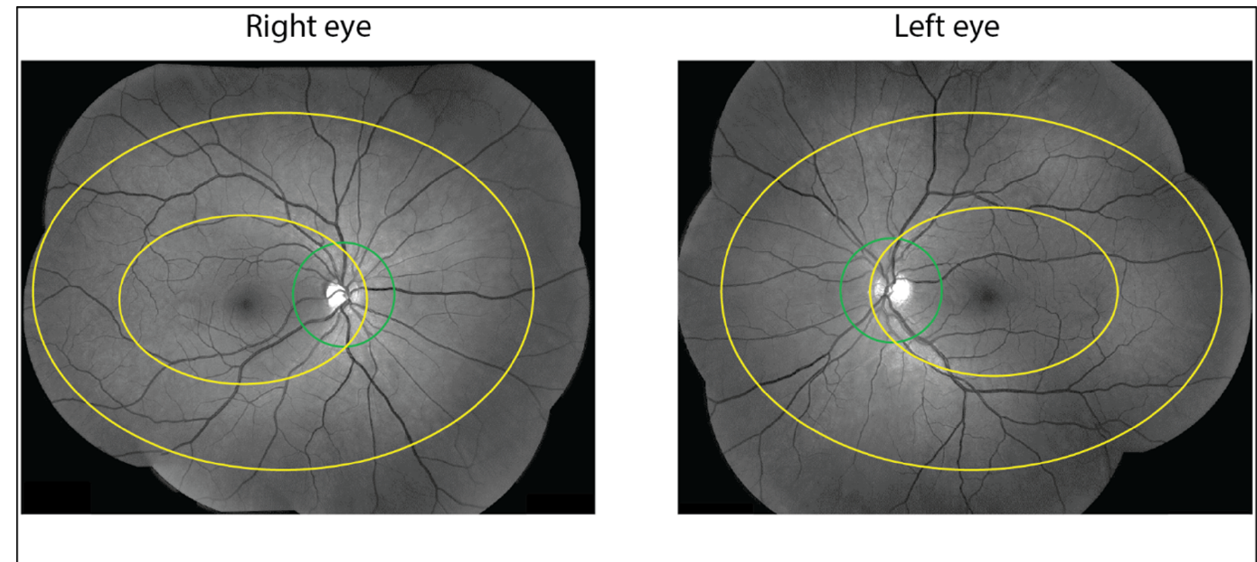
Figure 1. Relation between visual acuity after proton therapy and dose parameters by tumour localisation. Tumour localisation is done by classifying each tumour into central, mid-peripheral or peripheral localisation by considering the most centrally localised part of the tumour. Central tumours are localised within the temporal retinal arcade indicated by the small yellow oval. Mid-peripheral tumours are localised outside of this vascular arcade and are readily visible by indirect fundoscopy, indicated by the space between the small and big yellow oval. Peripheral tumours are localised further beyond and may be visualised by fundoscopy at angle or with the help of a mirror lens, indicated by the space outside the big yellow oval. Juxtapapillary tumours are defined as being localised within the green circle around the optic disc that extends 1 optic disc diameter beyond the edge.